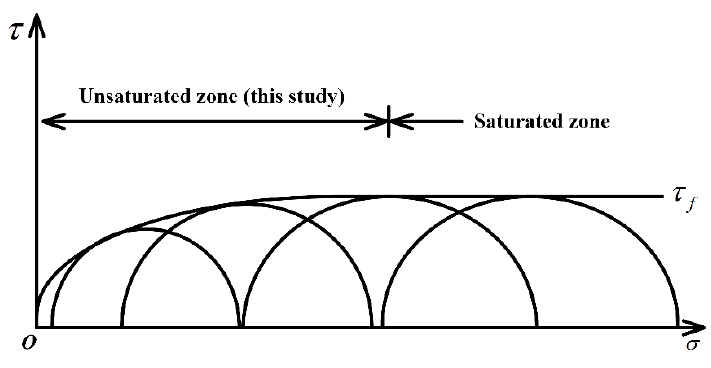
Figure 10. Consolidation undrained strength envelope of unsaturated clay.